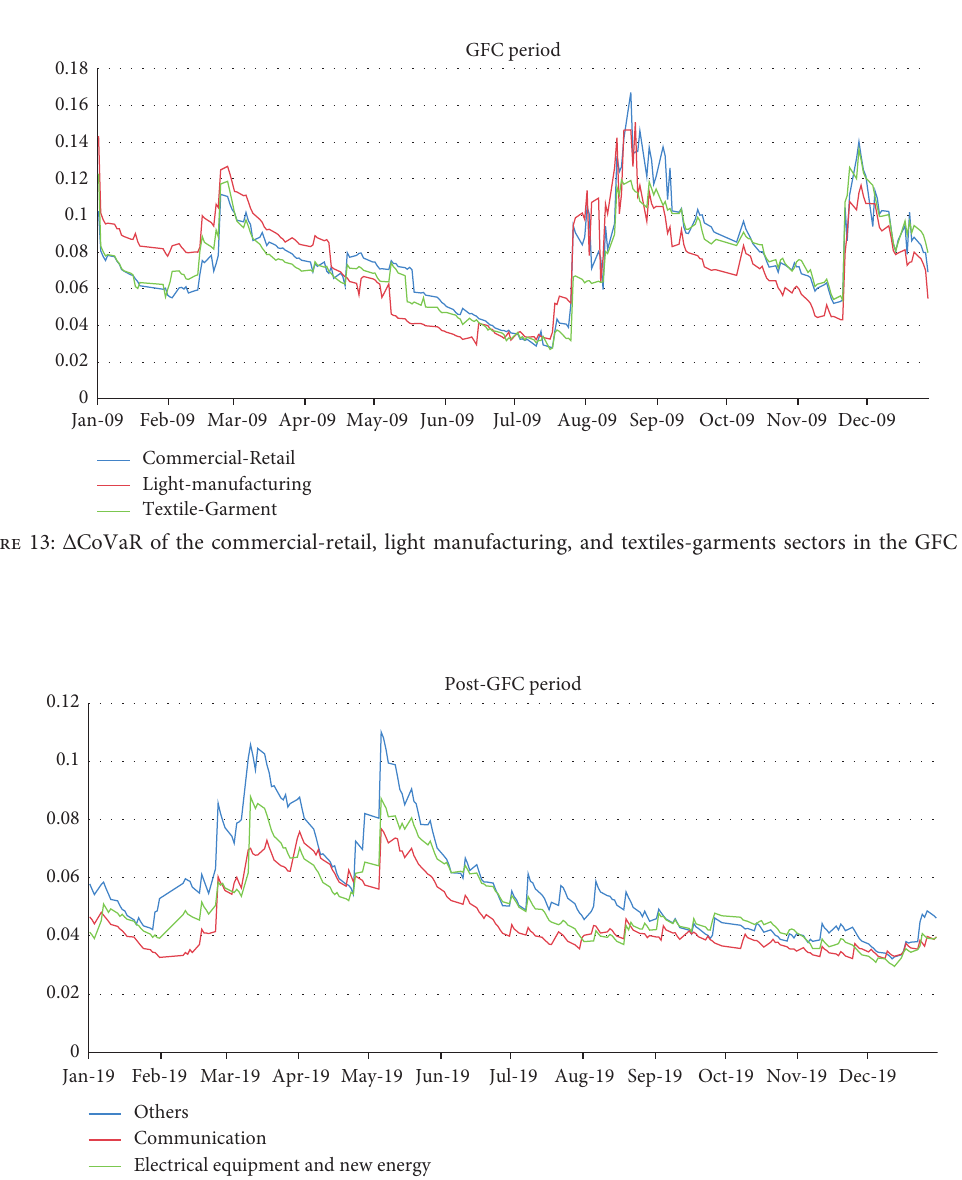
Figure 14: ∆ CoVaR of the communications, other, and electrical equipment and new energy sectors in the post-GFC